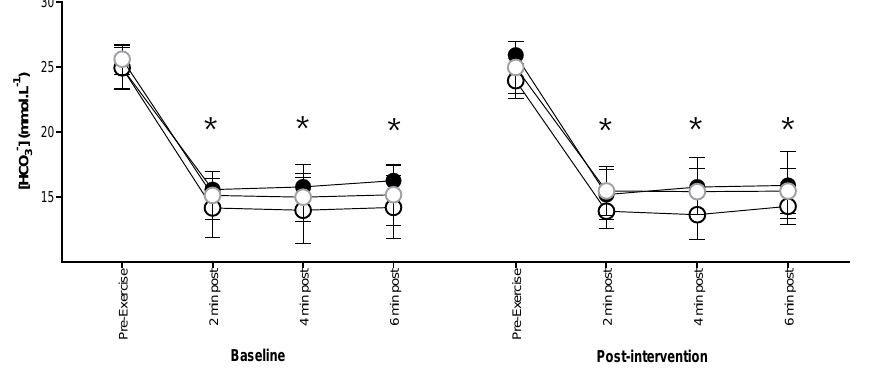
Figure 3. Blood [HCO 3 − ] for the high carbohydrate (HCHO), periodized carbohydrate (PCHO), and low carbohydrate high fat (LCHF) groups for baseline and post ‐ testing at pre ‐ exercise, plus 2, 4, and 6 min post ‐ test. * Significantly different to pre ‐ exercise ( p < 0.001).